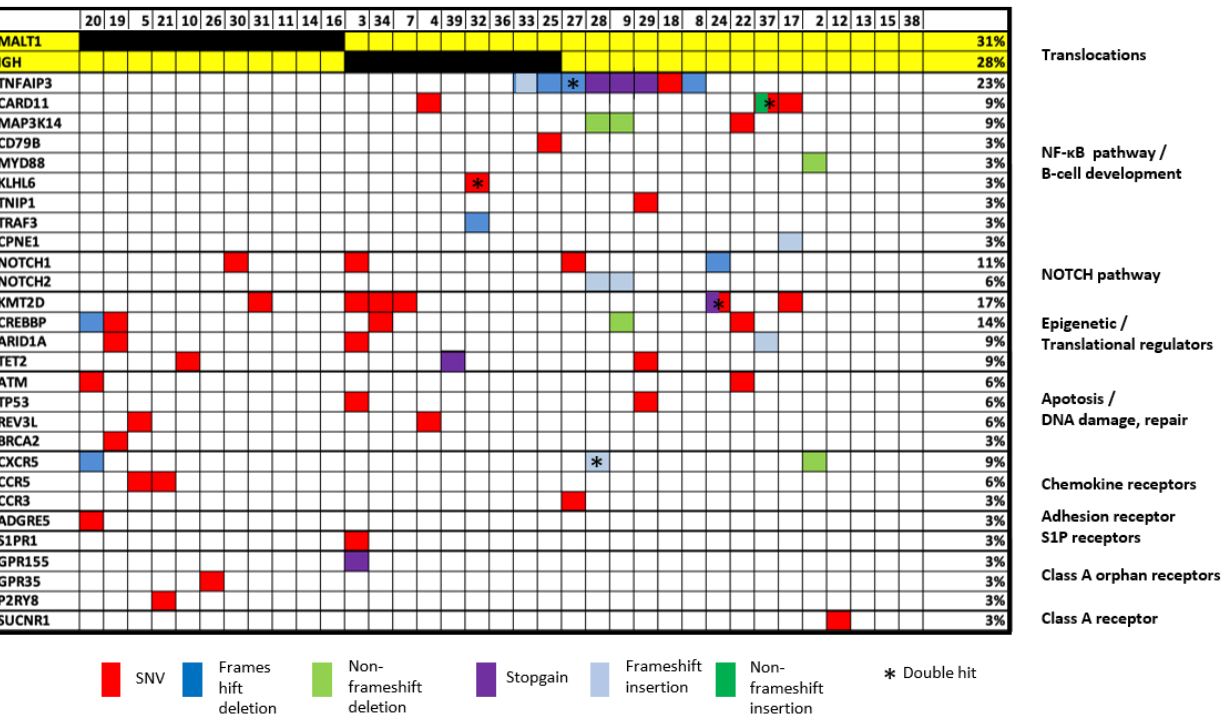
Figure 2. Distribution and characteristics of TNFAIP3 , NOTCH1 , KMT2D , and CREBBP mutations seen in H. pylori negative gastric MALT lymphoma. Black dots indicate truncating mutations, green dots missense mutations, and brown dots non- frameshift insertions/deletions. Functional domains are indicated once per gene in the respective color.